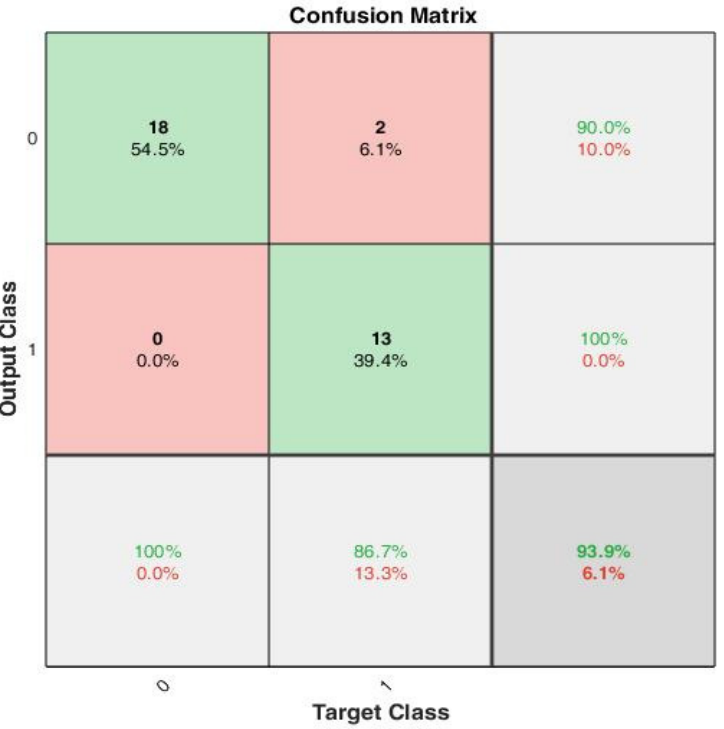
Figure 8. A confusion matrix that summarizes the model performance with true positivity rate and true negativity rate, with accuracy of 100%, 90% and 93.9%, respectively.